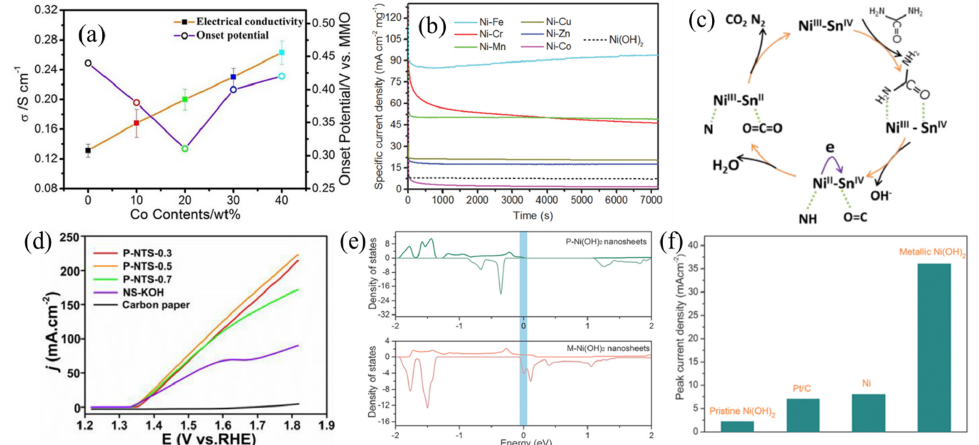
Figure 8. ( a ) Cobalt content dependence of electrical conductivity and onset potential; ( b ) chronoamperometric curves of Ni-M LDH in 1 M KOH and 0.33 M urea; ( c ) proposed reaction mechanism and ( d ) LSV curves of NiSn sulfide catalysts in 1 M KOH with 0.33 M urea; ( e ) density of states of S-doped and pristine Ni(OH) 2 and ( f ) comparison of peak current densities obtained in 1 M KOH and 0.33 M urea. ( a ) Reprinted with permission from Ref. [54]. ( b – d ) Reprinted with permission from Refs. [55,57]. ( e , f ) Reprinted with permission from Ref. [58]. Table 1. Comparison of UOR performances of various Ni-based catalysts.